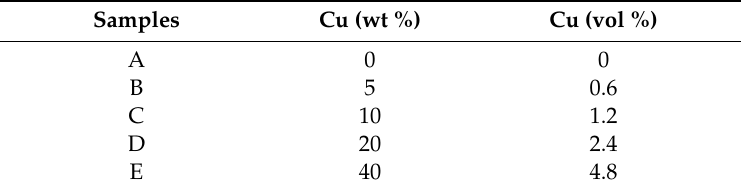
Table 1. Designation of composite samples due to the copper